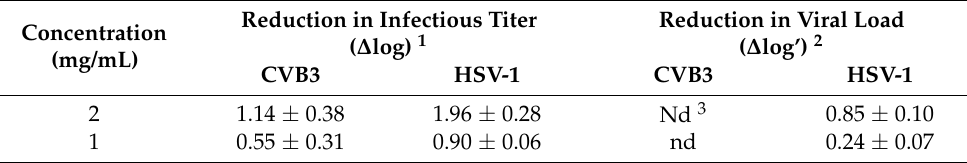
Figure 3. Endpoint dilution assays of CVB3 and HSV-1 titers in samples treated with CA extract. Table 4. Reduction in infectious titer and viral load by the CA extract.